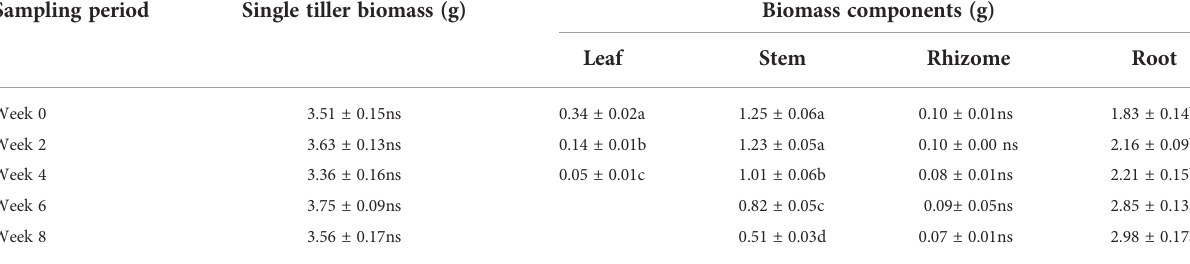
Data are presented as the mean ± SE. Each batch consisted of 5 replicates. Different letters indicate signi fi cant differences (p < 0.05). ns indicates no signi fi